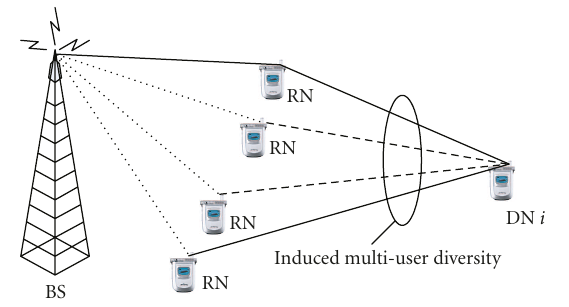
Figure 1: Conventional IMDR scheme.